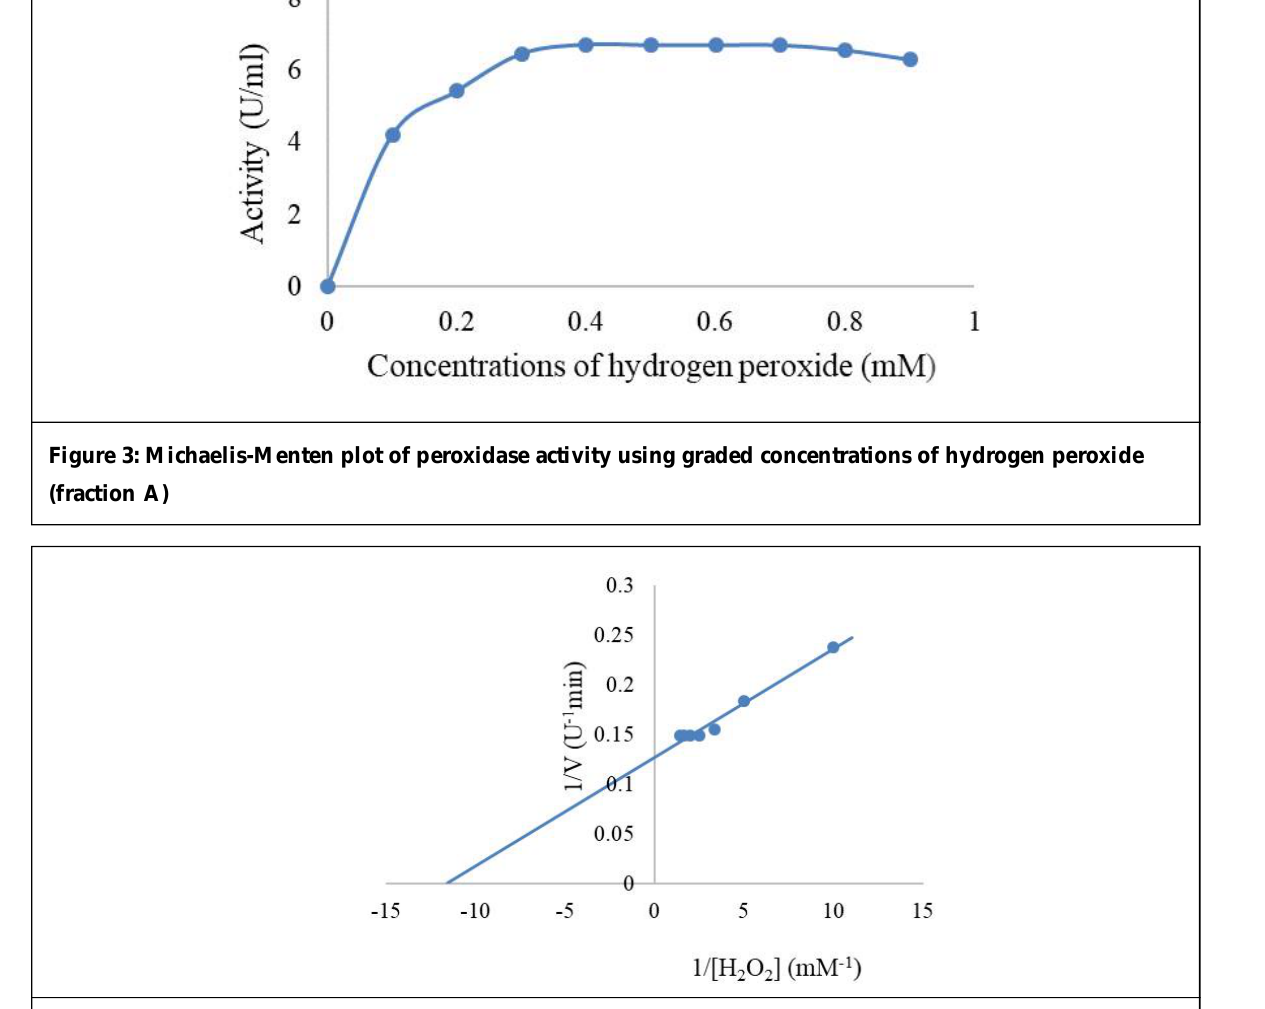
Figure 4: Lineweaver-Burk plot for peroxidase activity with graded concentrations of hydrogen peroxide (fraction